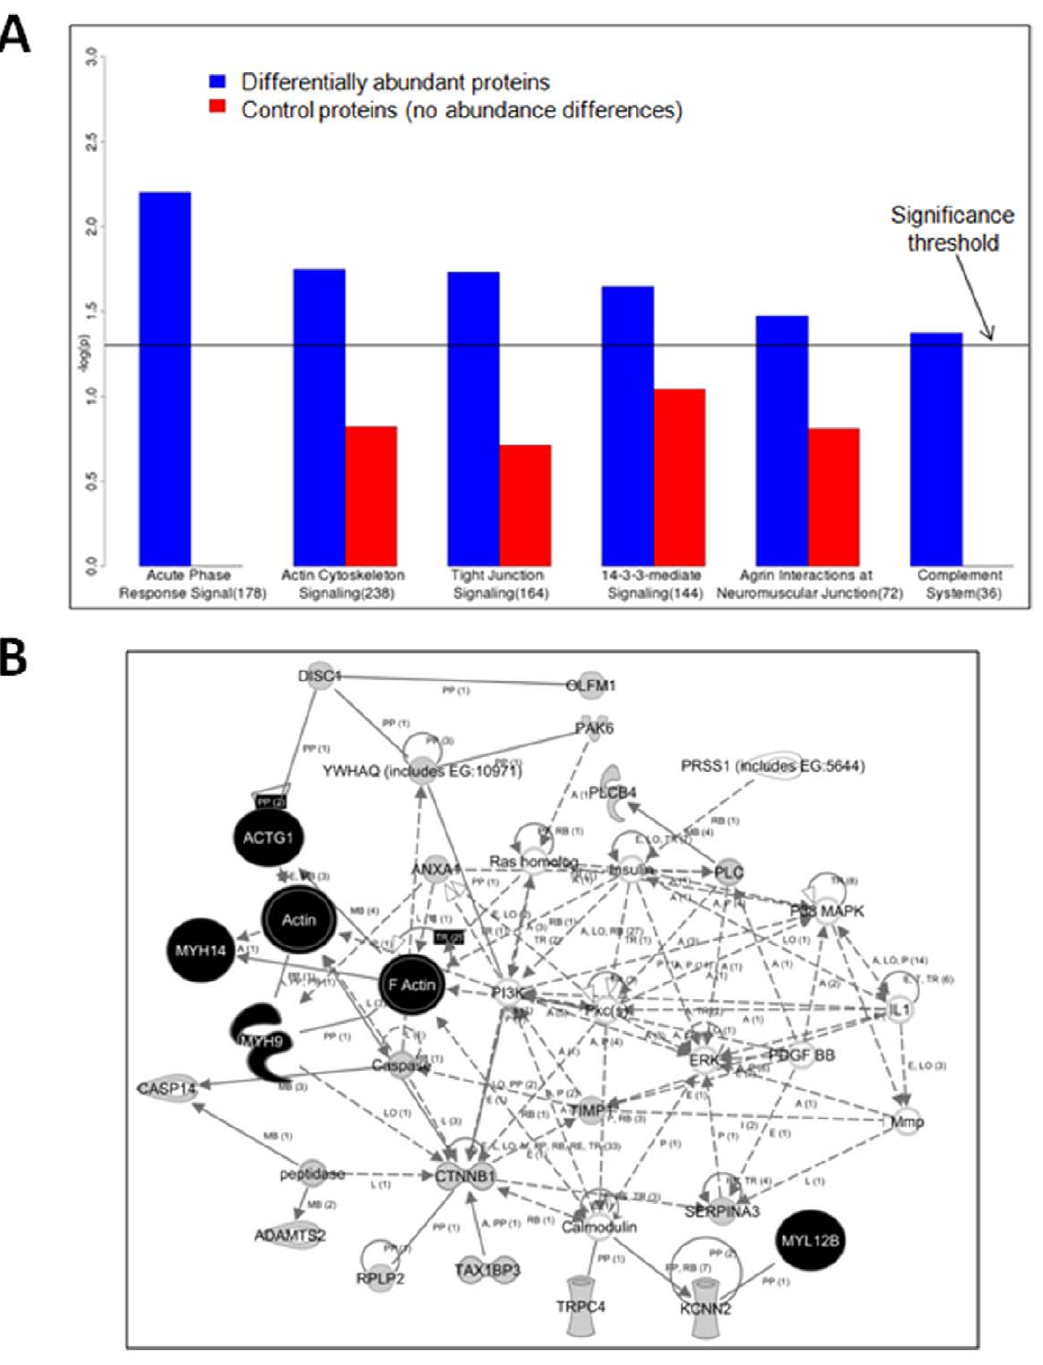
Figure 2. Bioinformatic analysis of differentially abundant proteins. A. Significantly represented pathways of differentially abundant proteins compared to control proteins (those showing no abundance differences) grouped by IPA. Pathways with bars rising above the significance threshold are those containing sufficiently high numbers of proteins from our proteomic data such that they are deemed highly represented in a statistically significant manner (See Materials and Methods for details on significance calculations). Numerical values in parentheses for each pathway are the total number of proteins in the Ingenuity Pathway database mapping to that pathway. B. A significantly represented protein network (P=1 6 10 2 35 ) determined by IPA on differentially abundant soluble saliva proteins. Myosin subunits and actins are highly represented in this network and shaded in black. Other differentially abundant proteins identified in our proteomics study are shaded in gray; proteins not identified in our proteomics study are not shaded.